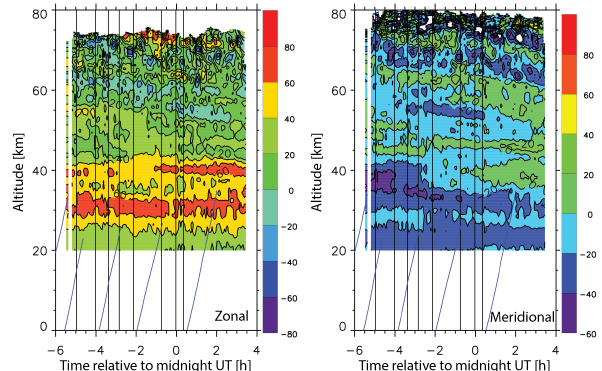
Figure 5. Contour plots of the wind field in ms − 1 as measured by DoRIS on 14/15 March 2015. Left: zonal winds, right: merid- ional winds. The vertical lines mark the launch times of the data- sondes. The slanted lines represent the time/height profiles of the radiosonde flights.